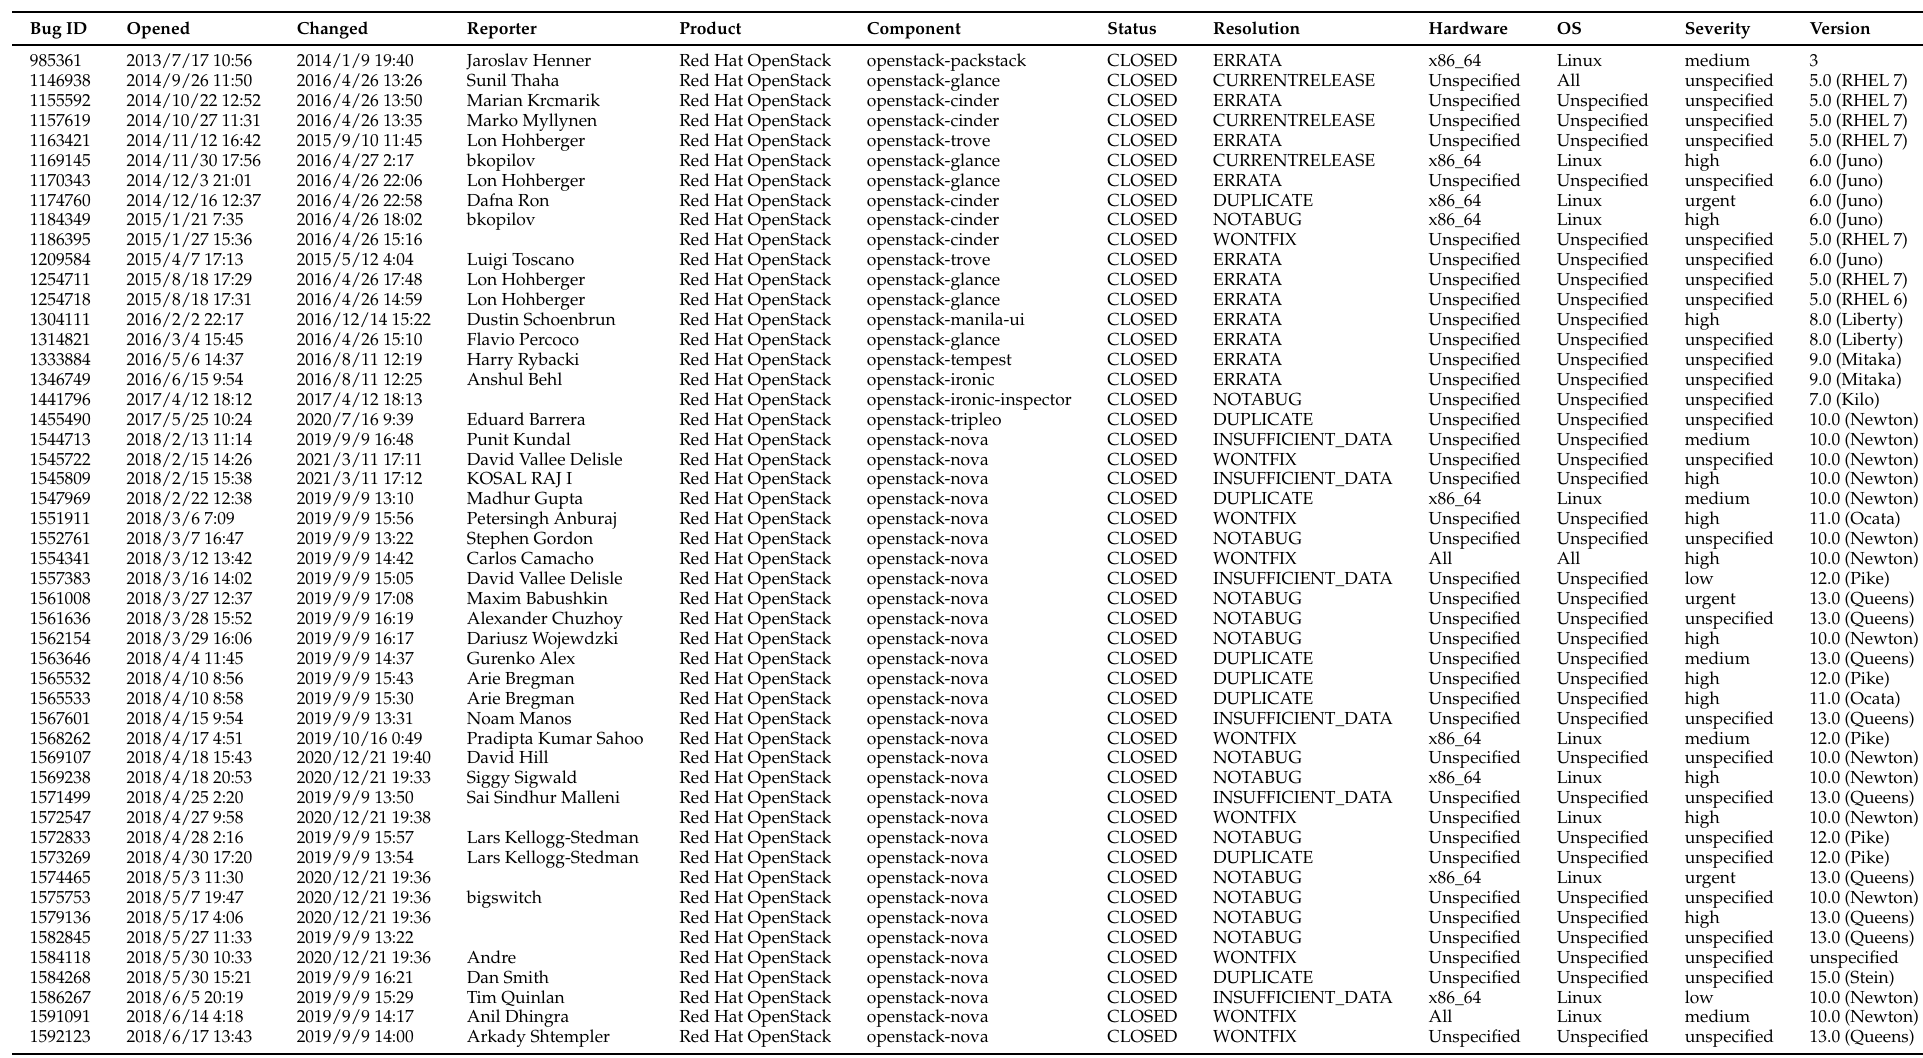
Table 1. A part of raw data logged on the bug-tracking